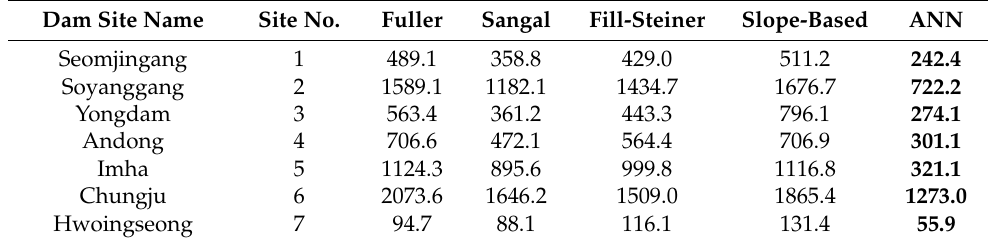
Table 5. Values of the root mean squared error (RMSE, mm) of the estimated peak flows with different methods.